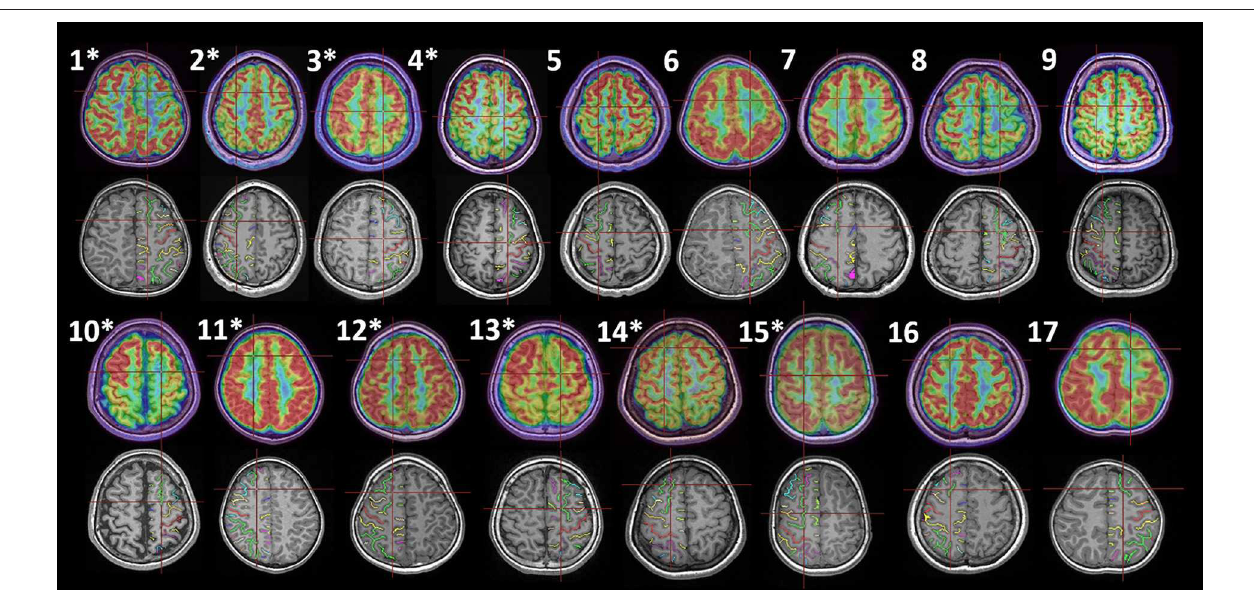
FIGURE 1 | Histologically proven FCD type II in the SFS of 17 patients. The upper and lower rows are group 1 (1–9) and group 2 (10–17), and the asterisks indicate cases with SEEG evaluation. For each patient, two coregistration images (MRI-PET and MRI-automatically identified sulci, Morphologist 2015, BrainVISA) with an identical axial position are displayed. The intersection of the red line demonstrates the location of the electrode contact, which is considered to be the seizure onset (1–4, 10–15) or the most apparent lesion (5–9, 16, 17). The green sulcus in the frontal lobe is the automatically recognized